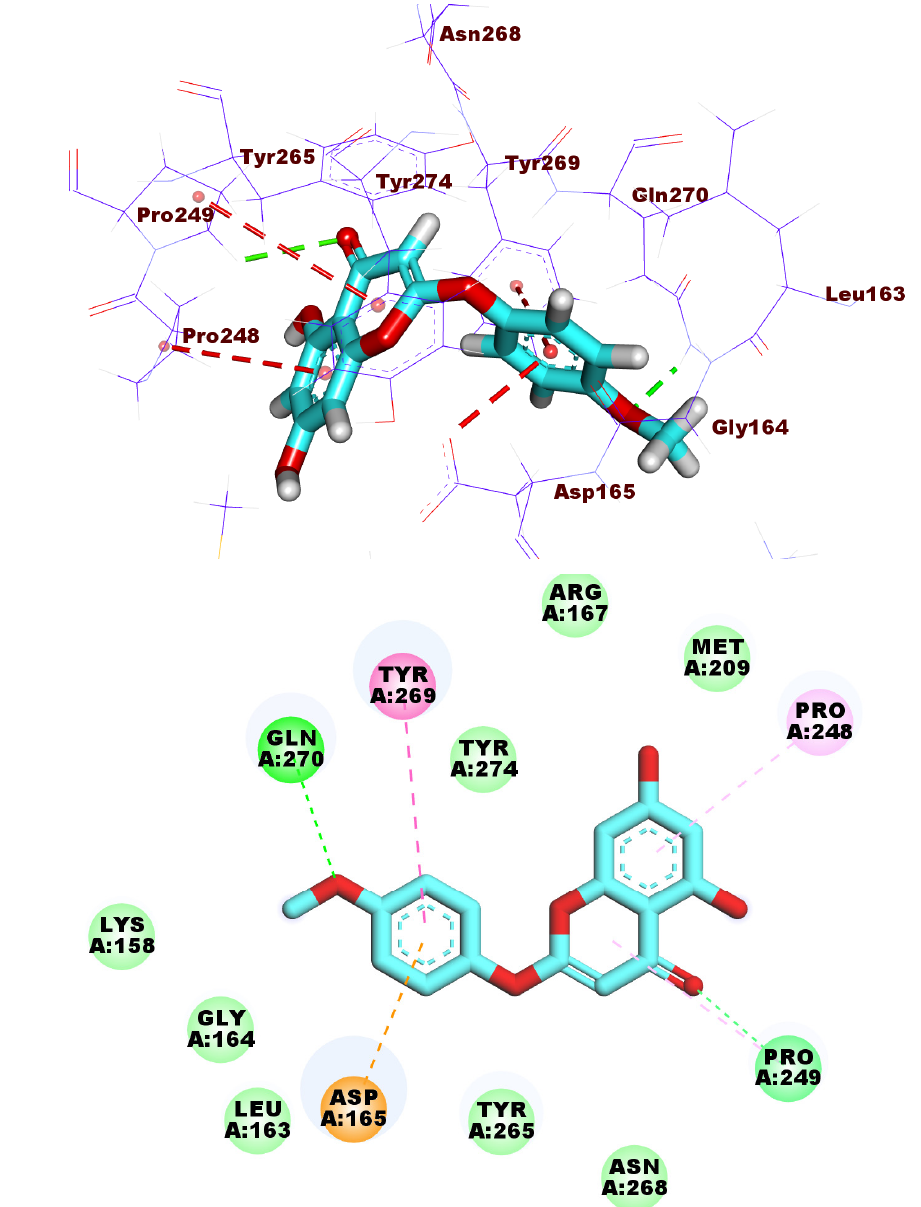
Figure 7. ( A ) 3D, ( B ) 2D and ( C ) Surface mapping of TTT inside the active site of PLP. The binding mode of 6-demethoxy-4`-O-capillarsine ( 1 ) exhibited a binding free en- ergy of -18.86 kcal/mol. The anisole moiety was directed into the first pocket of PLP form- ing one H- bond with the amino acid, Gln270, in addition to two hydrophobic interactions with the amino acids, Tyr269 and Asp165. The 5,7-dihydroxy-4H-chromen-4-one part oc- cupied the second pocket of PLP forming a H- bond with the amino acid Pro249 besides two hydrophobic bonds with the amino acids Pro248 and Pro249 (Figure 8A–C).